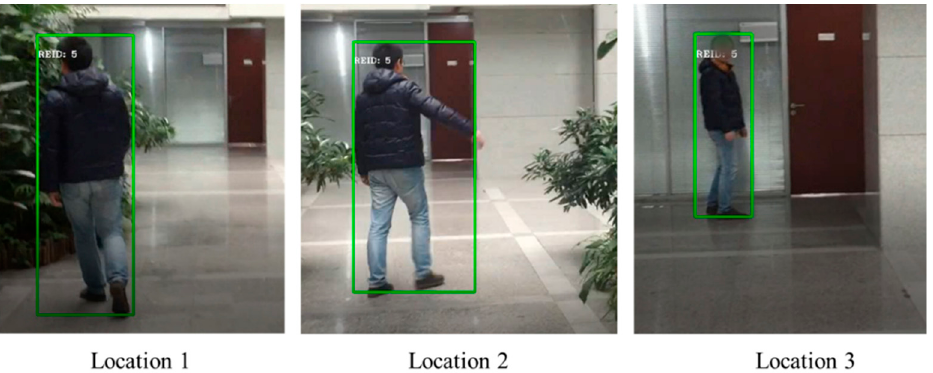
Figure 6. A long period tracking in the view of robotics with DPA model. Our method is applied to help keep following the target person for a long period with interference and occlusion.